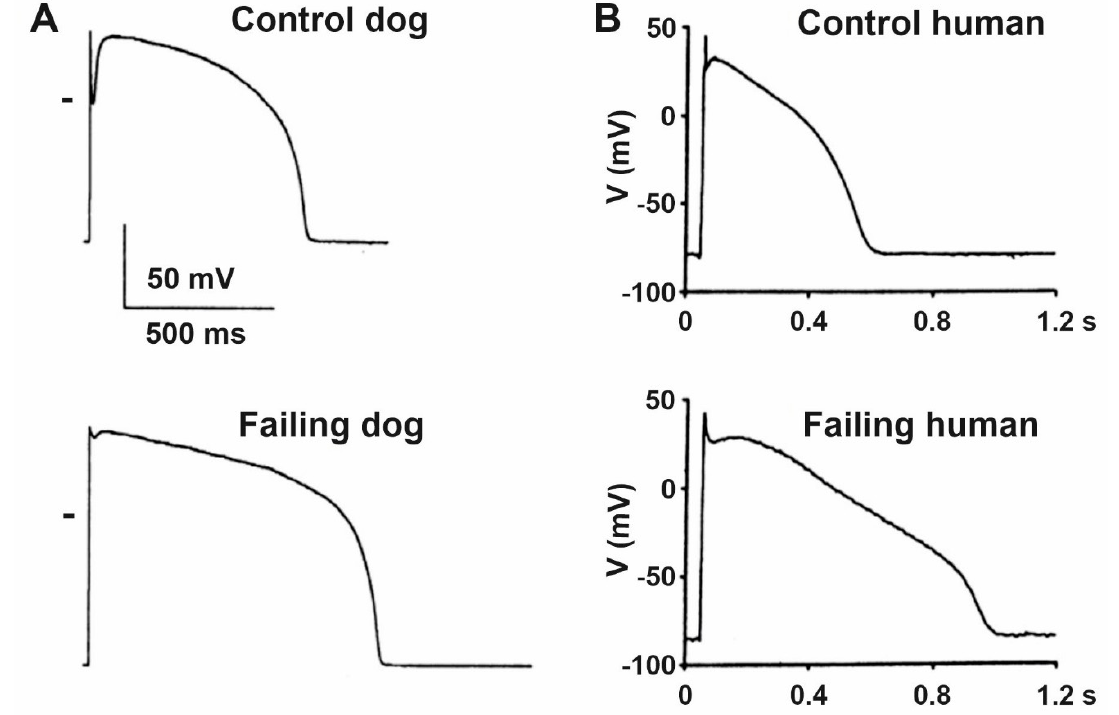
Figure 2. Characteristic ventricular action potentials from control and failing ( A ) dog and ( B ) human ventricular cardiomyocytes show significantly prolonged action potentials with impaired early repolarization notch. Zero voltage is indicated by short bars on panel ( A ) [11,33] .